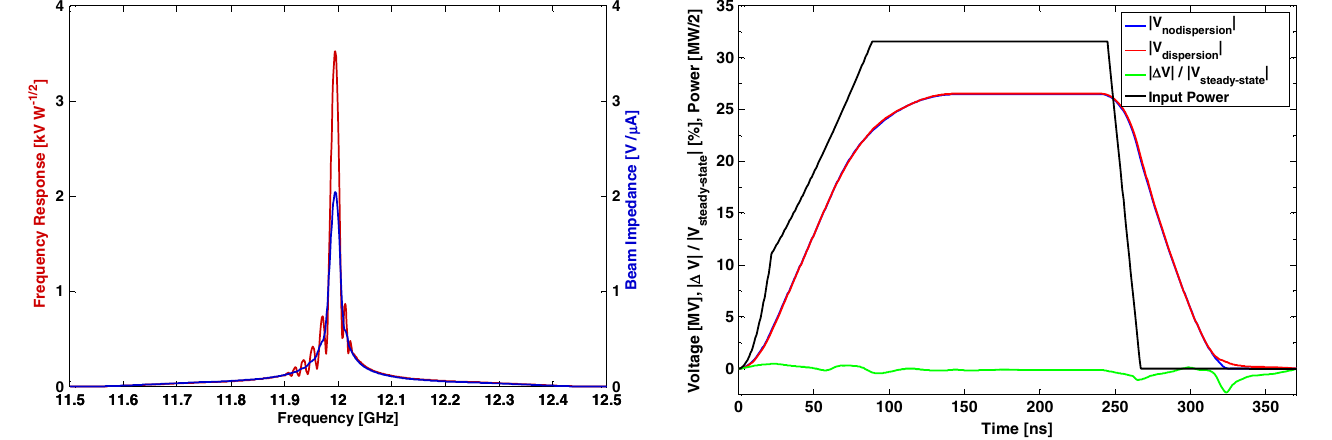
FIG. 4. Complex magnitudes of the unloaded voltage with (red) and without (blue) dispersion for the analytical compensa- tion pulse (black), dispersion effect (green).